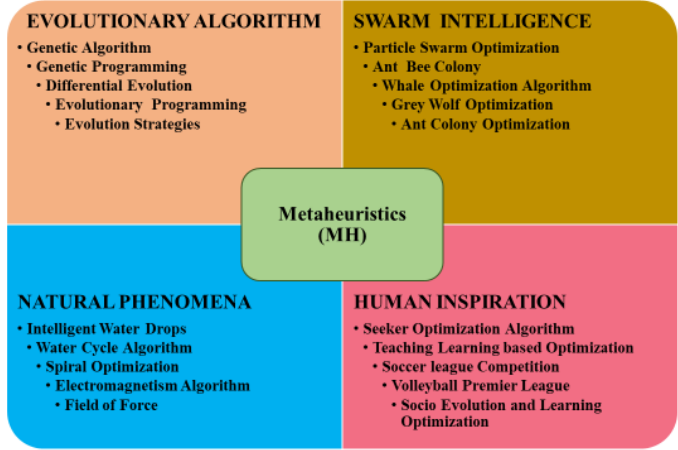
Figure 2. Metaheuristic model